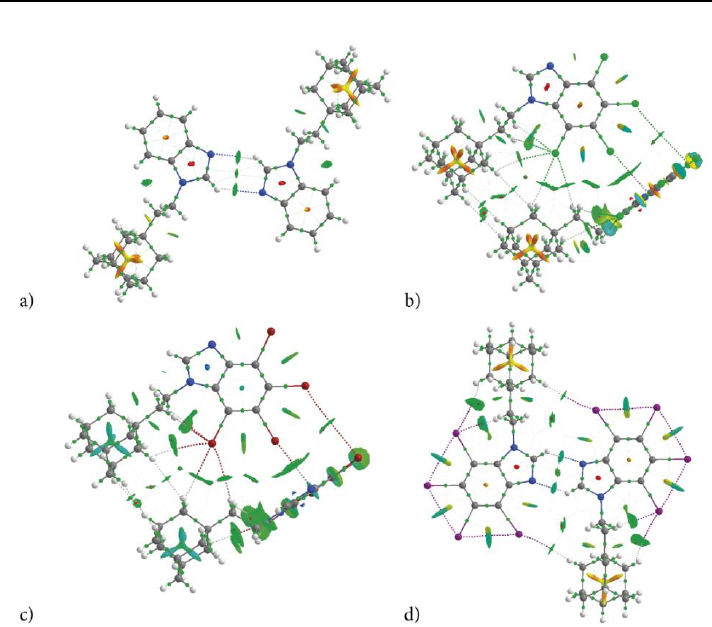
Figure 8. Molecular graph of dimers cut of crystalline structure of congeners (bond critical point, BCP—small green points, ring critical point, RCP—small red points) ( a ) AB, ( b ) tClAB, ( c ) tBrAB and ( d ) tIAB. The isosurface of reduced density gradient surface (RGD = 0.5) with sign( λ 2 ) ρ BCP is mapped over the surface visualize interacting regions. Color scale is − 0.03 (blue) to 0.03 a.u.